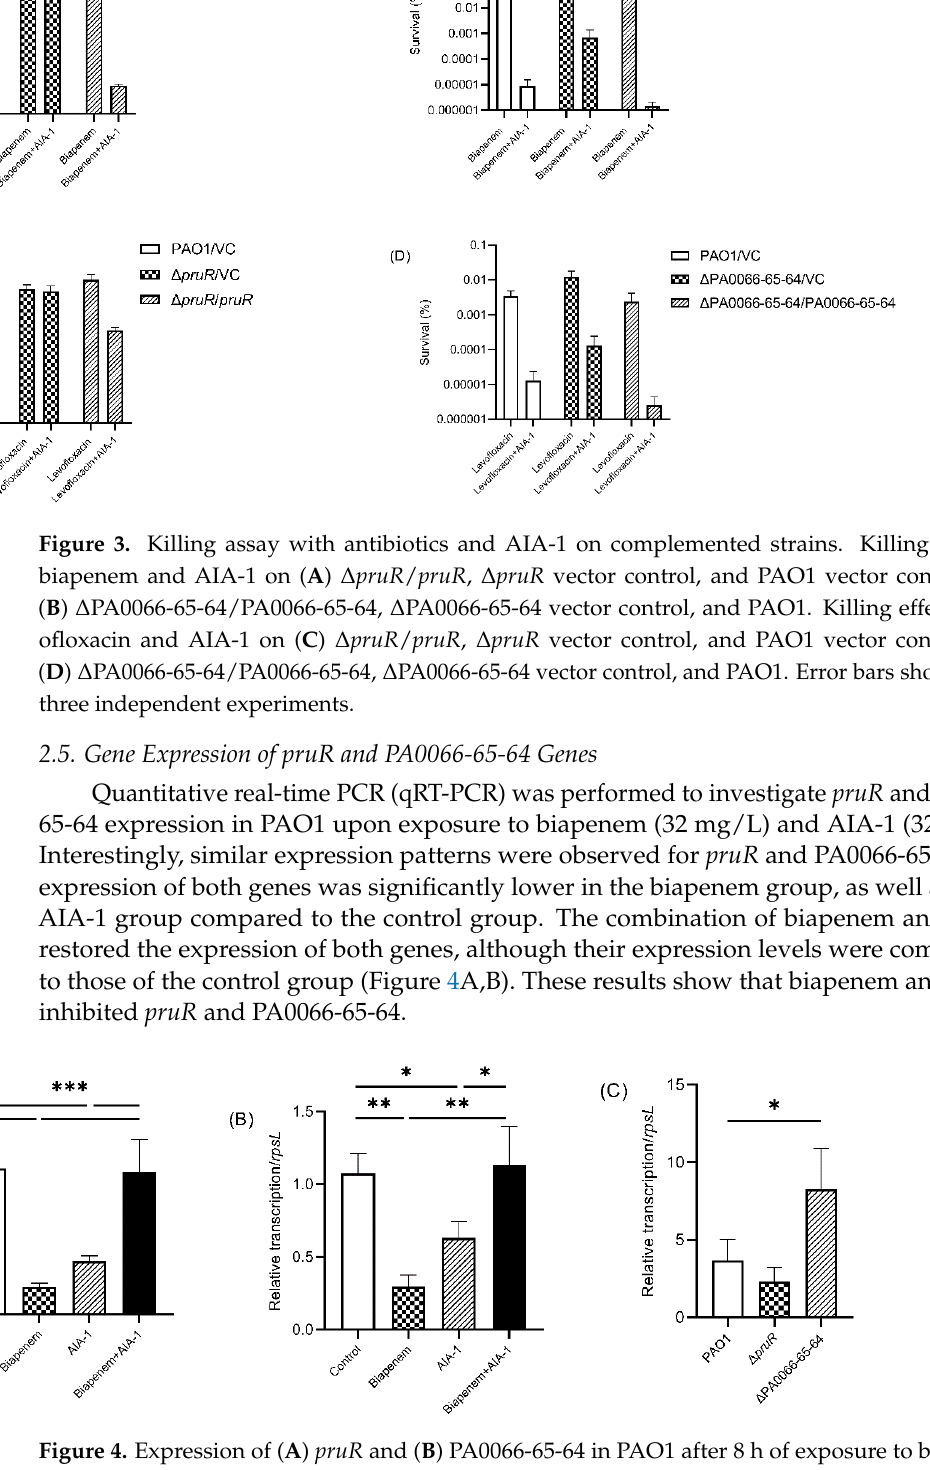
Figure 4. Expression of ( A ) pruR and ( B ) PA0066 ‐ 65 ‐ 64 in PAO1 after 8 h of exposure to biapenem, AIA ‐ 1, and combination of both, and ( C ) expression of rpoS in deletion mutants following 12 ‐ h cul ‐ ture, gene expression was normalized to rpsL , n = 3, * p < 0.05, ** p < 0.01, *** p <